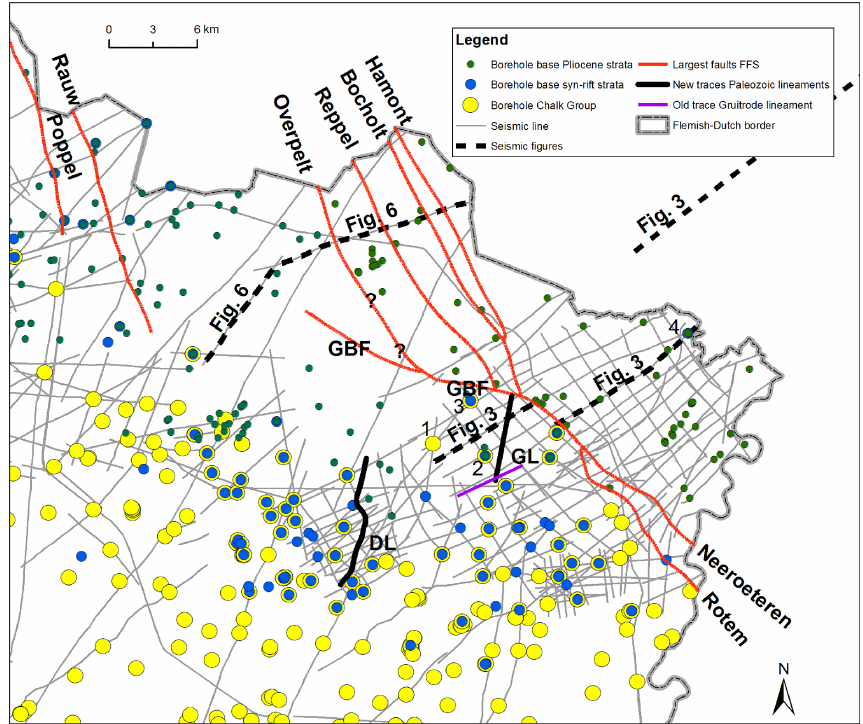
Figure 5. Overview map of the main input data used for the G3Dv3 model of the area, namely seismic lines and borehole selections (for mapping of the bases of the Pliocene, syn-rift strata, and Chalk Group). The composite seismic sections of Figs. 3 and 6 are marked in bold dashed lines. The numbers of the boreholes in Fig. 3 are indicated. The modeled major fault lines of the FFS are marked by red lines, while the modeled axes of the late Paleozoic Donderslag Lineament (DL) and Gruitrode Lineament (GL) are marked by black lines. The old trace of the Gruitrode Lineament by Langenaeker (2000) is shown in purple. Question marks indicate uncertainties in the fault trace.